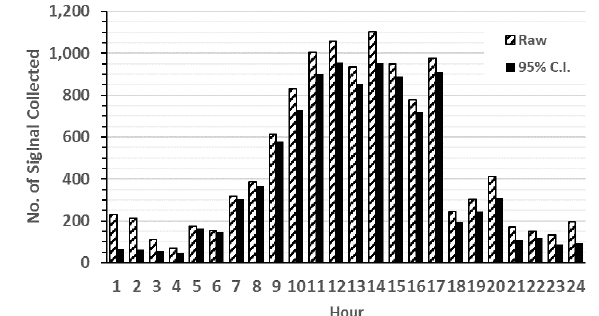
Figure 14 Dominant frequencies of all sensors for a month (Jan.